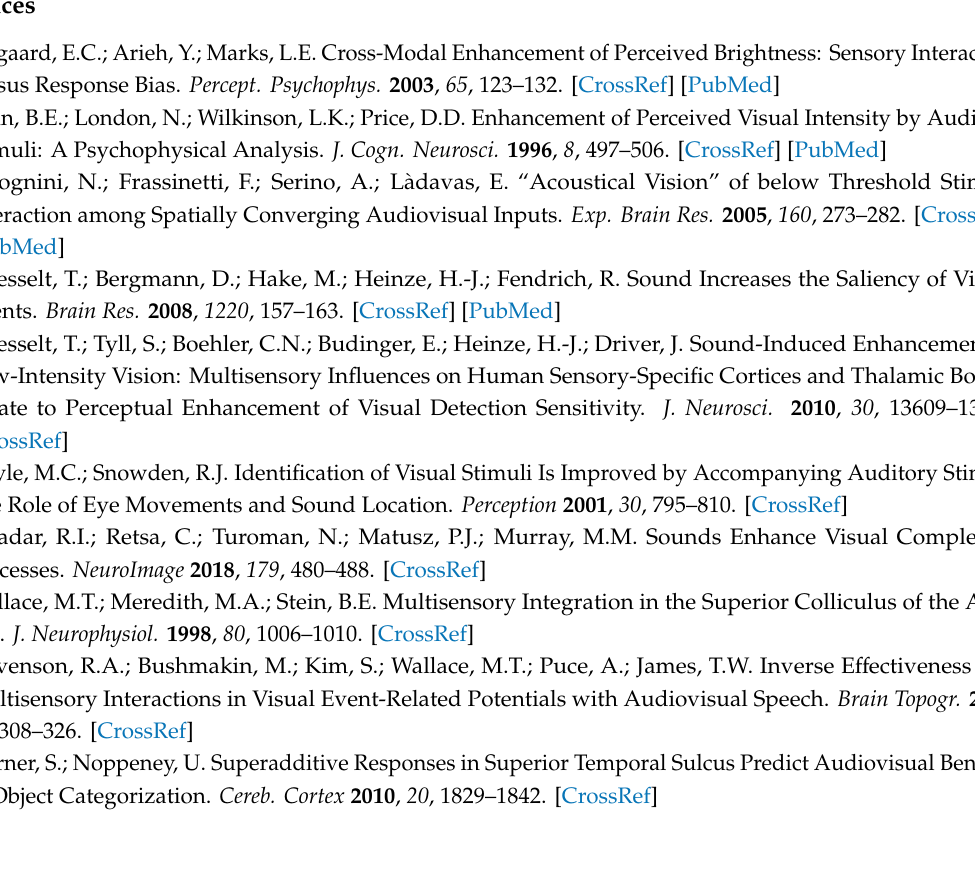
Figure S1. Threshold, slope, and RT di ff erence across auditory salience levels. Green: Enhancement group; Orange: Suppression group; Figure S2. Threshold, slope, and RT di ff erence aligned to individual participants’ optimal auditory salience; Table S1. Results of overall statistical analysis; Table S2. Results of statistical analysis based on data aligned by optimal auditory